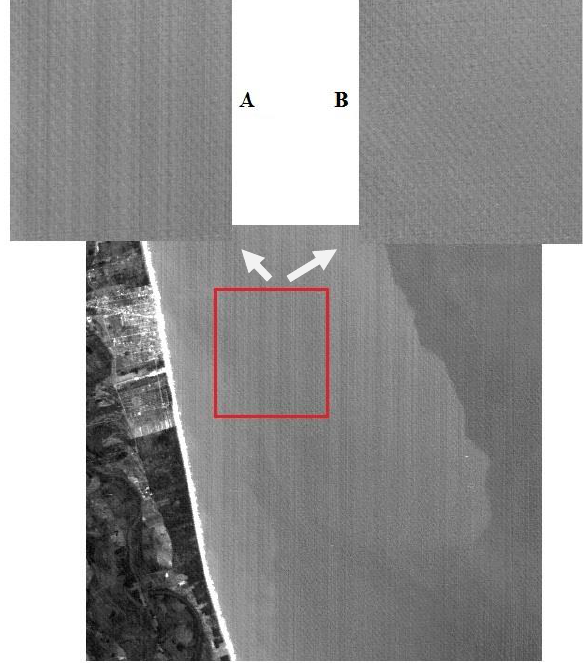
Figure 3. The image acquired in band 1of CBERS 2 CCD Camera: A) a part of the original image. B) The result of vertical striping noise removal in original image